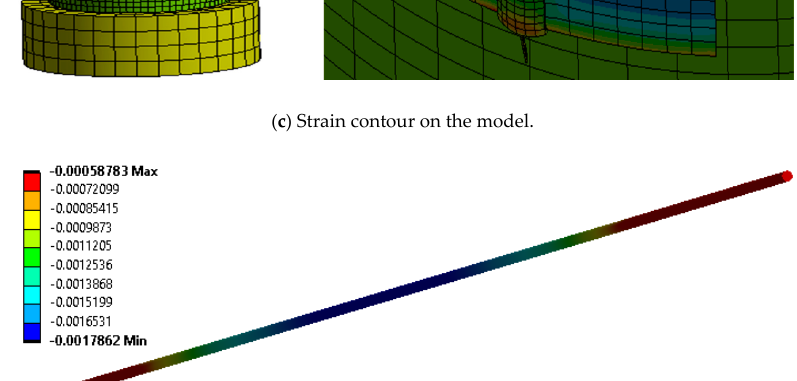
Table 6. FBG Pack specification for FEM analysis.